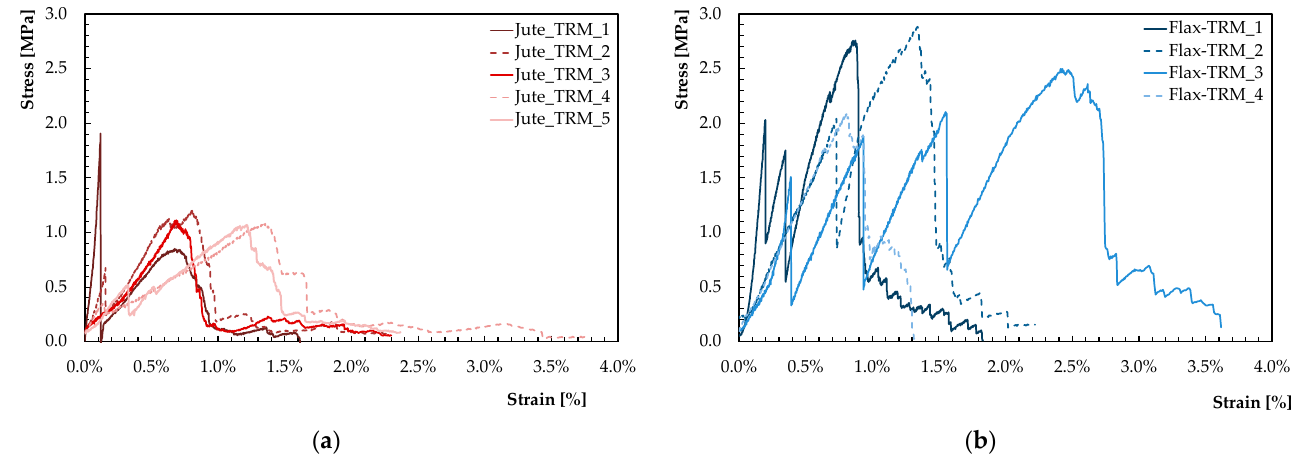
Figure 16. Stress–strain curves of Jute-TRM ( a ) and Flax-TRM ( b ). By observing the different curves obtained and comparing them with other reference studies [14,23,26], it is possible to identify, to different degrees, some common